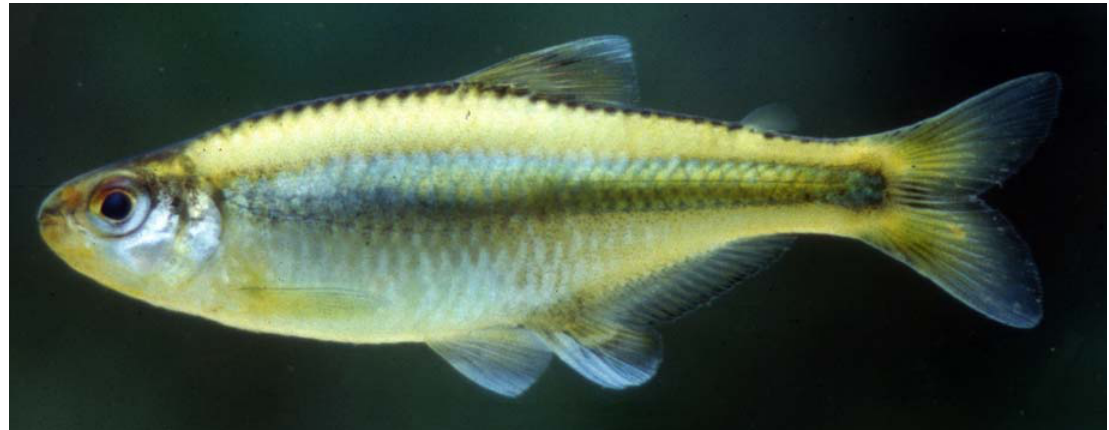
Fig. 2. Bryconadenos tanaothoros , new species, MCP 29476, SL 43.5 mm, adult male. Brazil: Mato Grosso, rio Ferro on the road between Novo Mato Grosso and Nova Ubiratã, about 25 km SW of Novo Mato Grosso, upper rio Xingu basin, GPS coordinates 13°3’32"S 55°2’12"W. Sexually active male specimen freshly fixed in formalin. The dark chromatophores of this specimen associated with the lateral line are contracted and barely visible anteriorly and do not show at all posteriorly. The position of the anal-fin gland can be seen as a yellowish brown oval area just posterior to the proximal end of the white pigment along the anterior border of the anal fin.